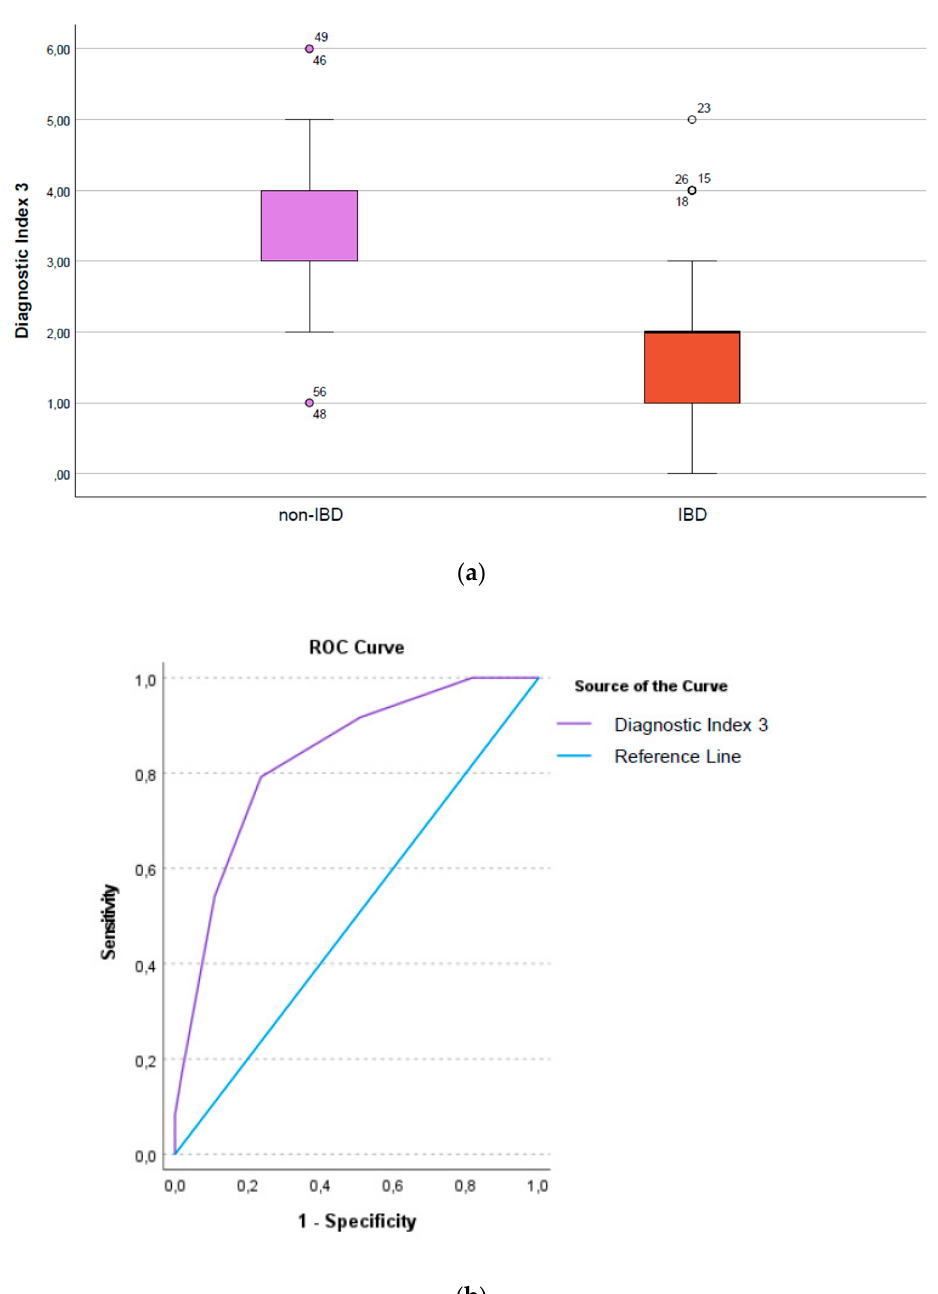
Figure 3. ( a ) Boxplot illustrating the Diagnostic Index3, differentiating non-IBD from IBD patients; ( b ) Roc curve showing the AUC of the Diagnostic Index 3, differentiating non-IBD from IBD patients.